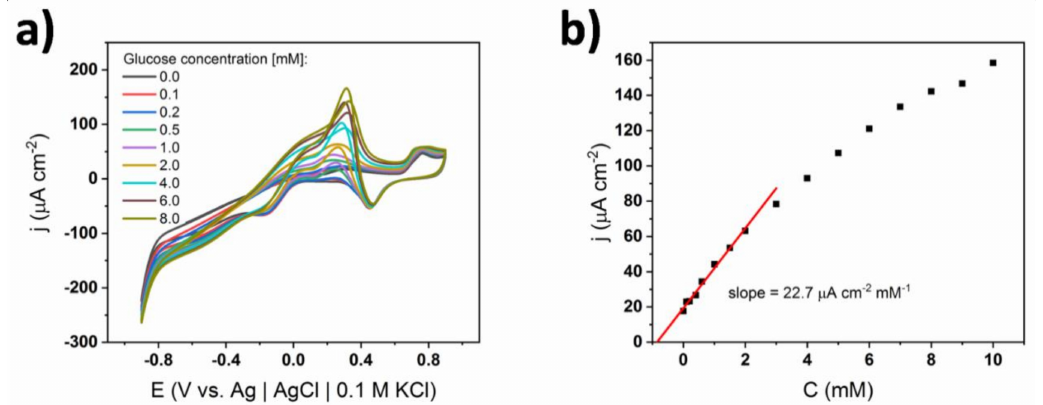
Figure 4. ( a ) Cyclic voltammograms of bare TiND | AuNP electrode registered for di ff erent glucose concentrations in 0.01 M self-made phosphate PBS (sPBS), ( b ) calibration curve depicting the change of the current density at the glucose oxidation peak ( + 0.35 V).